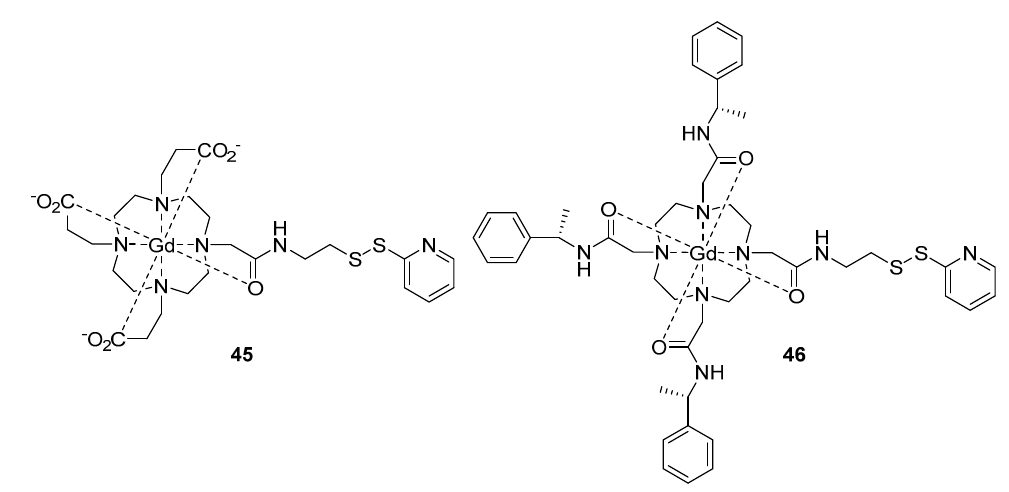
Figure 11. Gadolinium (III) spin labels DOTA chelate 45 and C1 46 with phenylethylamine